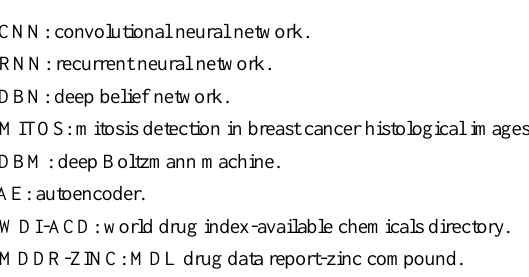
The classification accuracy of drug-like/nondrug–like models